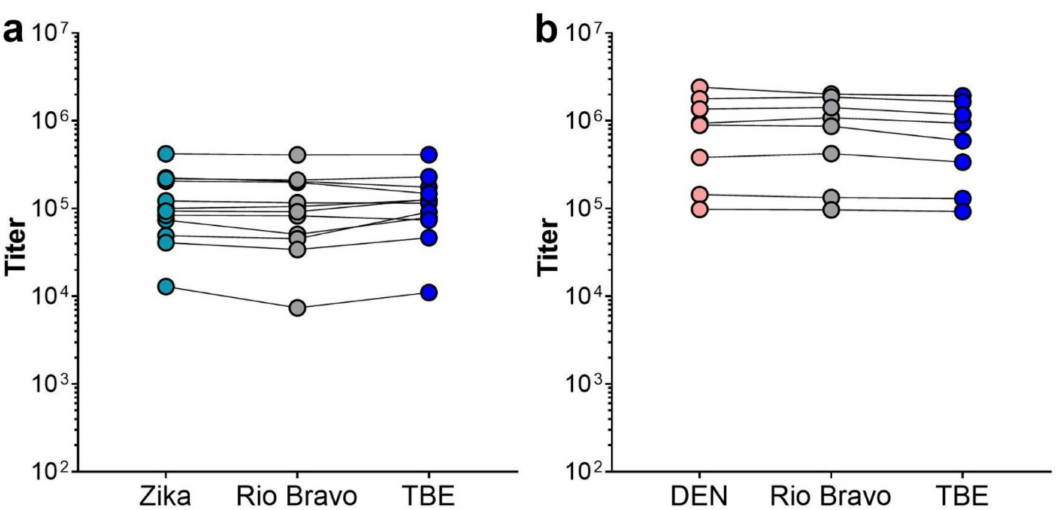
Figure 4. IgG ELISAs with sE antigens from different flaviviruses. Samples from 12 Zika ( a ) and 8 dengue ( b ) patients with pre-existing TBE immunity were analyzed with the sE of the corresponding infecting virus (Zika, turquoise circles in ( a ); dengue, light red circles in ( b )) as well as Rio Bravo (grey circles) and TBE sE (blue circles). ( a ) Serum samples Z1, Z3, Z5, Z6, Z7, Z8, Z9, Z10, Z12, Z14, Z15, and Z16 from Table 3. ( b ) Serum samples D1, D2, D3, D5, D6, D7, D9, and D12 from Table 4. ANOVA revealed no significant differences between IgG titers obtained with the homologous and heterologous